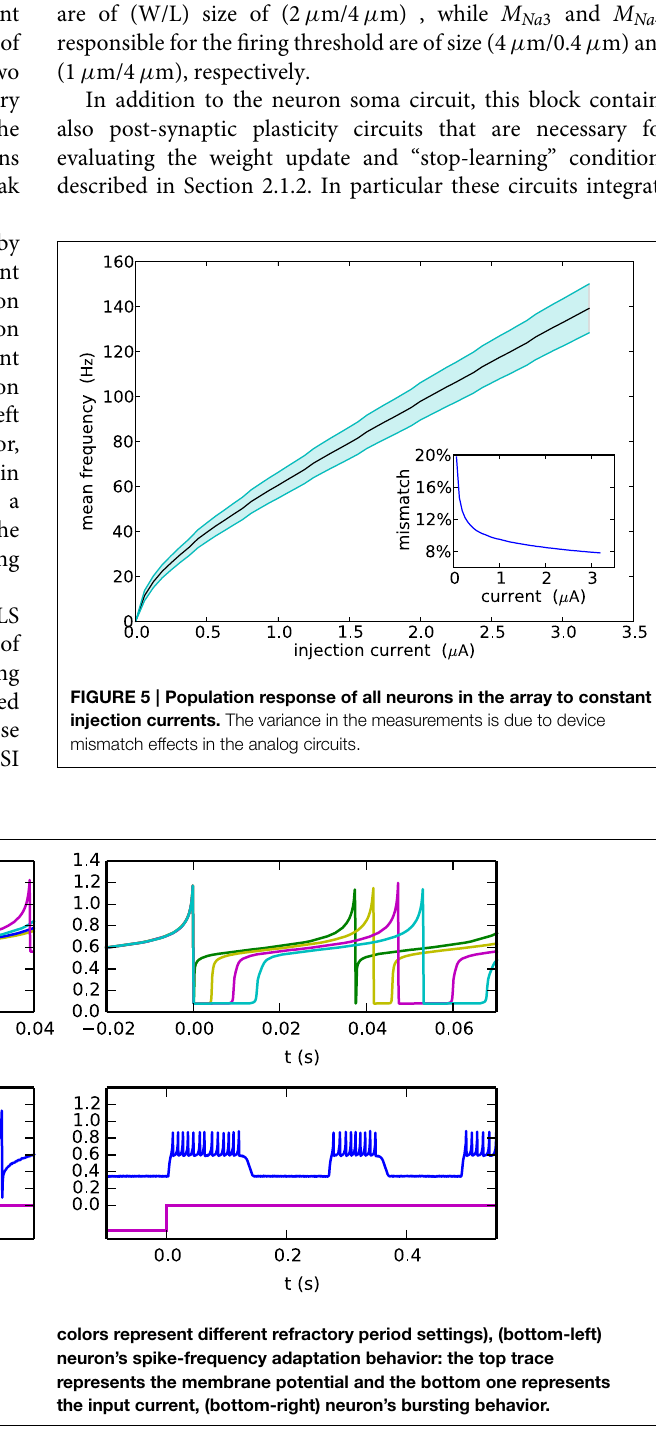
Frontiers in Neuroscience |